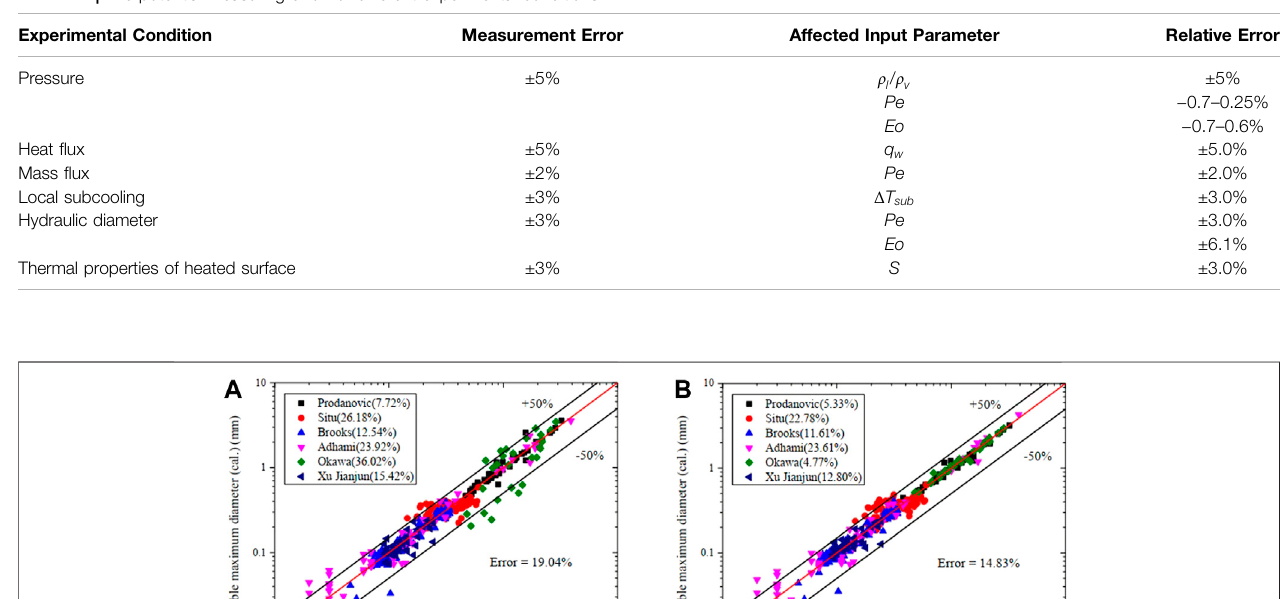
Frontiers in Energy Research |